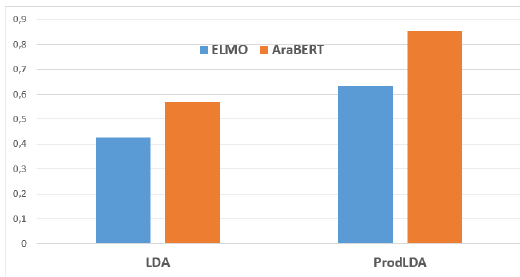
Figure 3 . NPMI of different models.